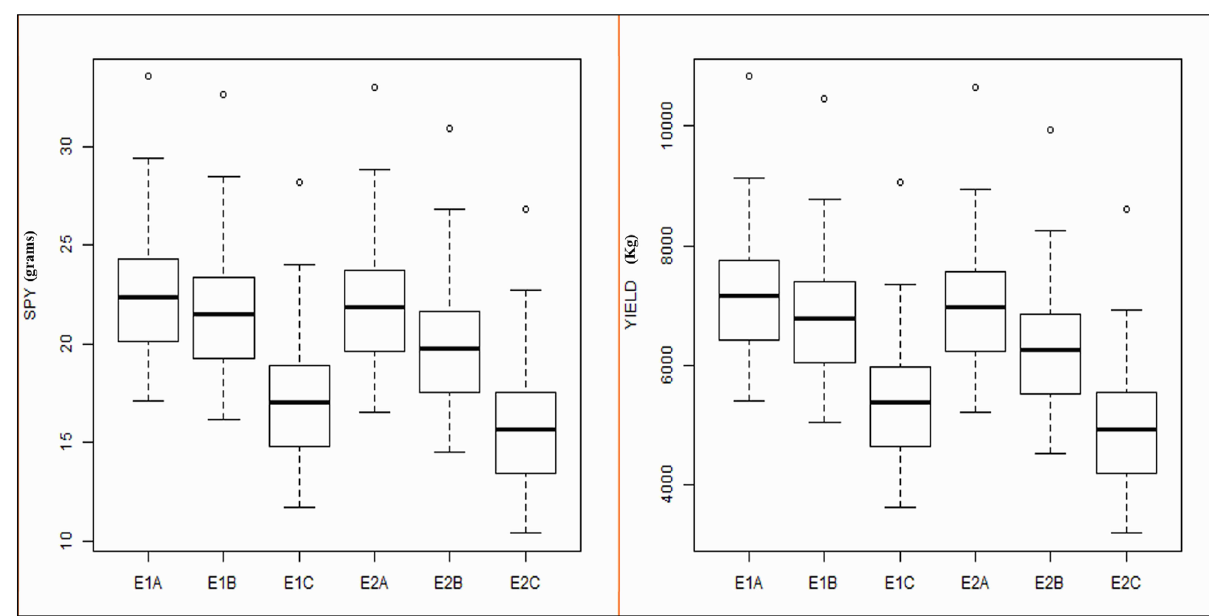
Figure 1. Box plot representation of genotypes performance for SPY and Yield traits across the